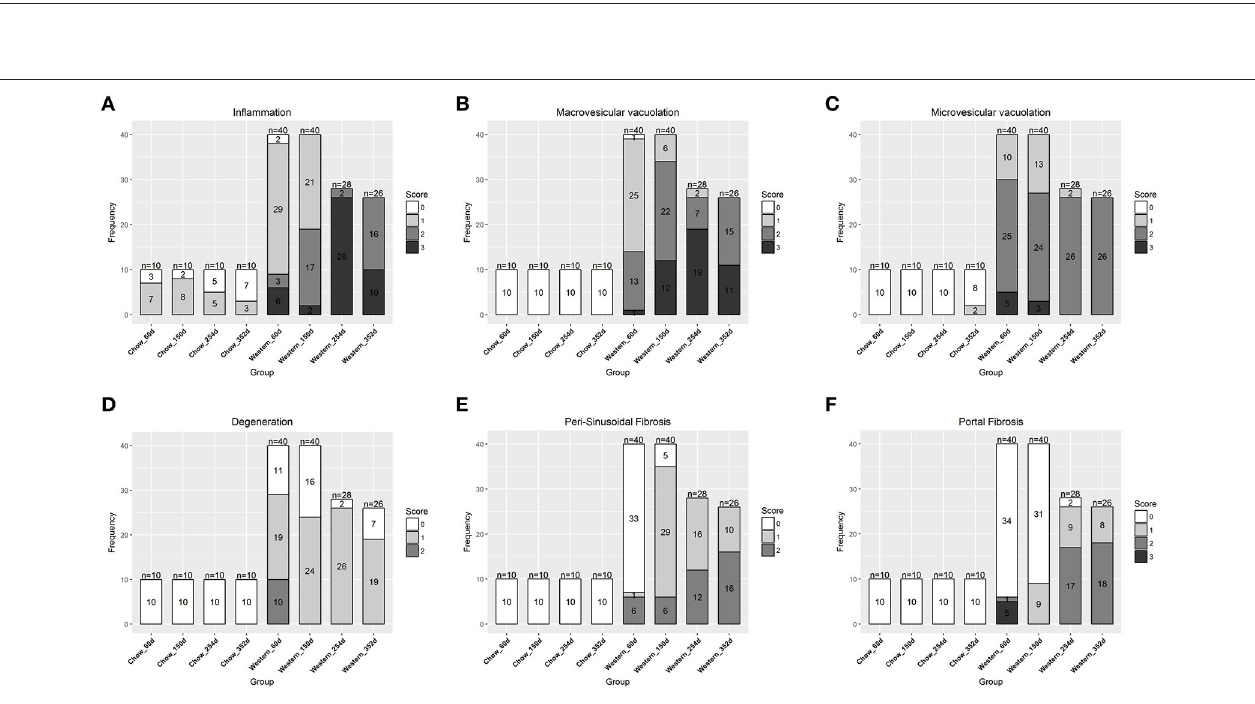
Frontiers in Pharmacology | www.frontiersin.org